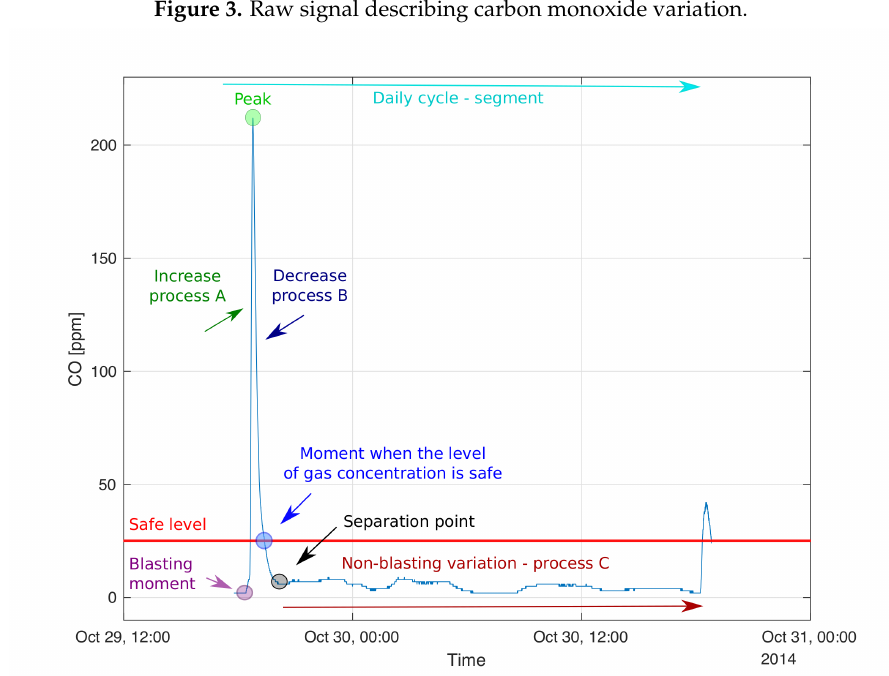
Figure 4. The schematic idea of the analyzed process responsible for the carbon monoxide